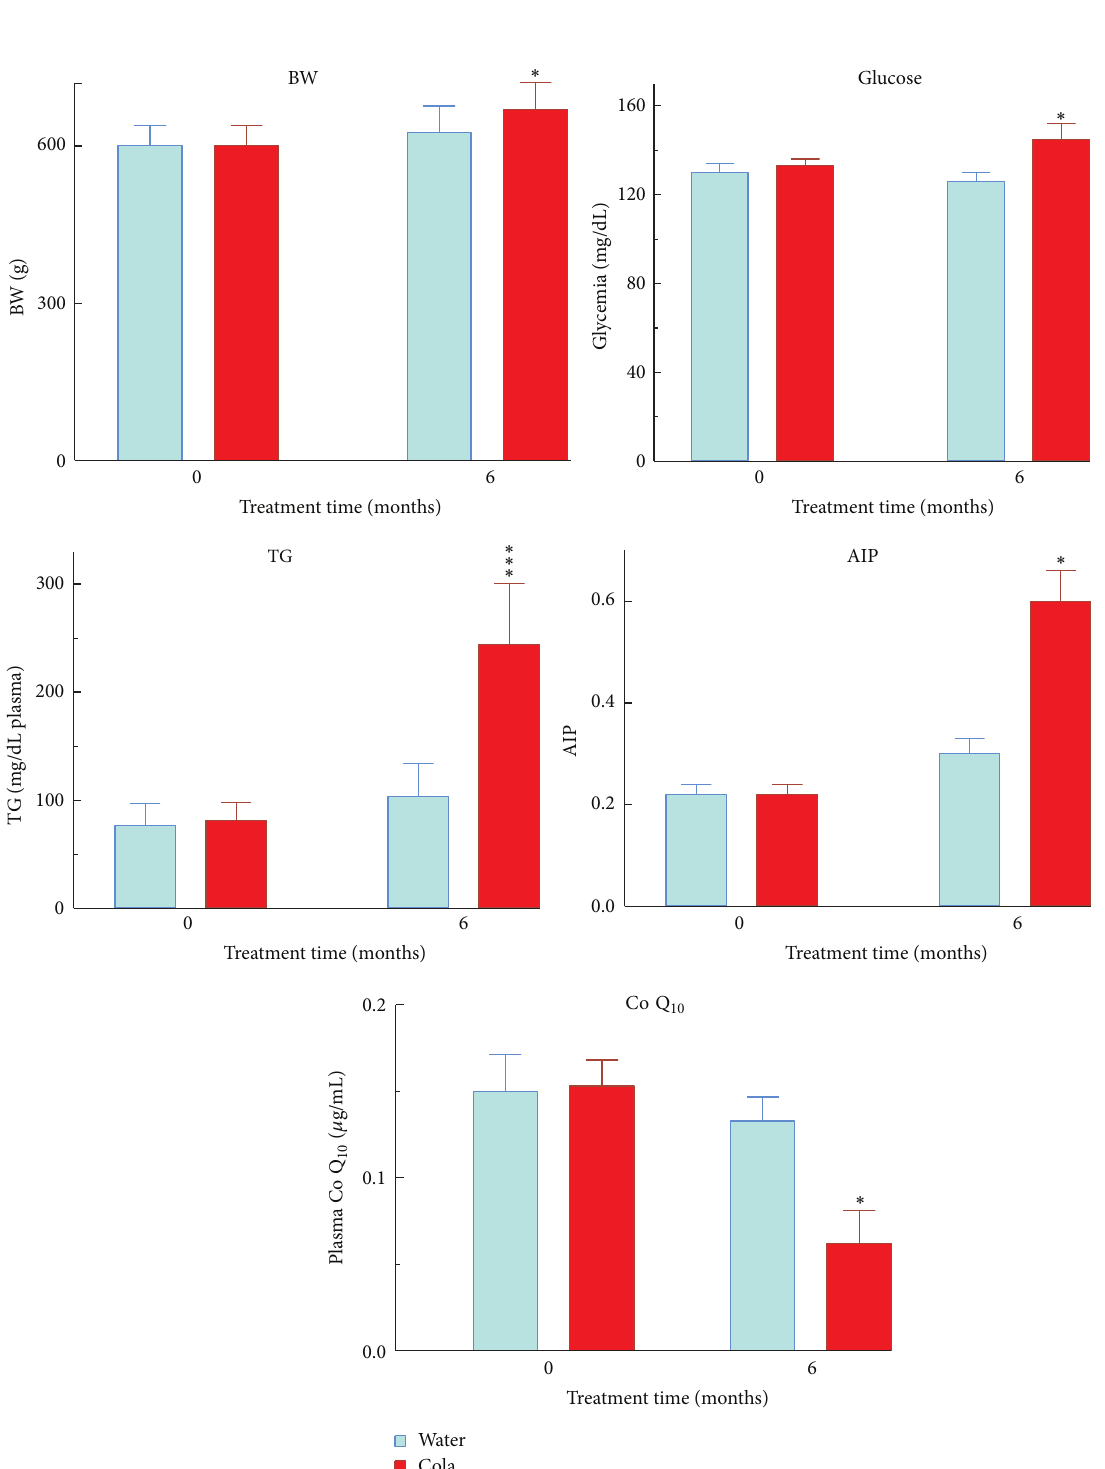
Figure 1: Body weight, biochemical profile (general metabolism), and Q 10 level before and after cola treatment. BW: body weight, TG: triglycerides, AIP: atherogenic index in plasma, and Q 10 : coenzyme Q 10 (ubiquinone Q 10 ). ∗ 𝑝 < 0.05 and ∗∗∗ 𝑝 < 0.001 . Compared with W, C rats showed overweight (+8%, 𝑝 < 0.05 ), hyperglycemia (+11%, 𝑝 < 0.05 ), hypertriglyceridemia (2-fold, 𝑝 < 0.001 ), higher AIP (2-fold, − 55%, 𝑝 < 0.05 𝑝 < 0.01 ), and lower Q 10 levels (